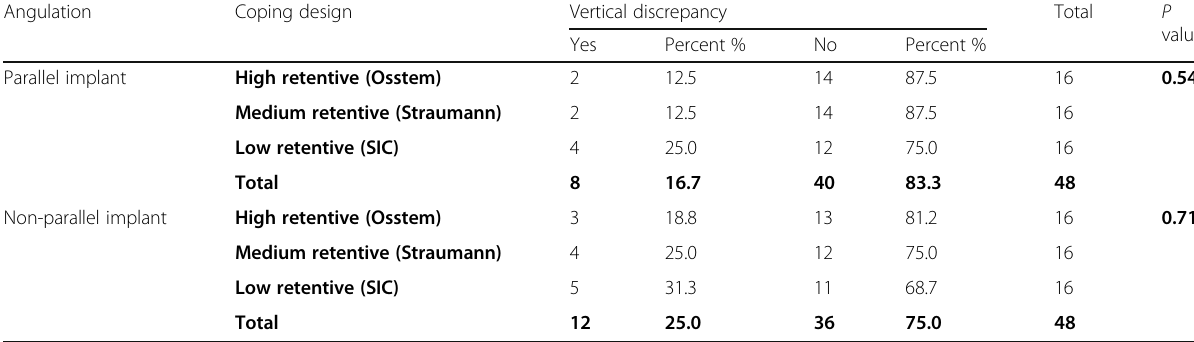
Table 6 Effect of implant angulation of the open tray coping designs on vertical discrepancy